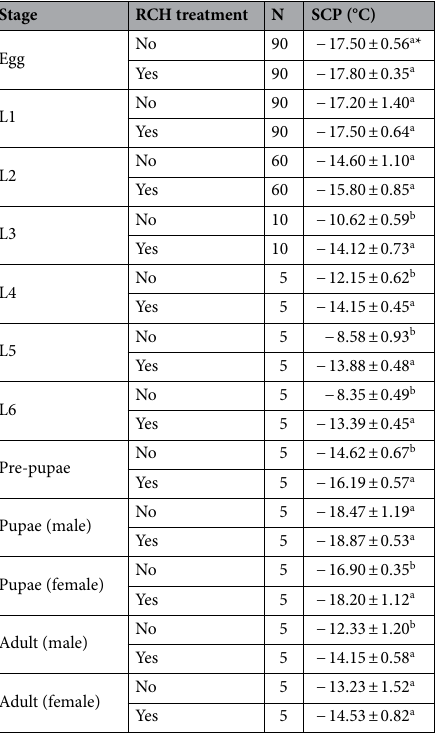
Table 2. Changes in supercooling points of Spodoptera frugiperda after rapid cold hardening treatment (5 °C for 6 h). Each treatment was replicated three times with different individuals per replication. *Different superscript letters indicate significant difference between means for each SCP (Type I error = 0.05, LSD test).